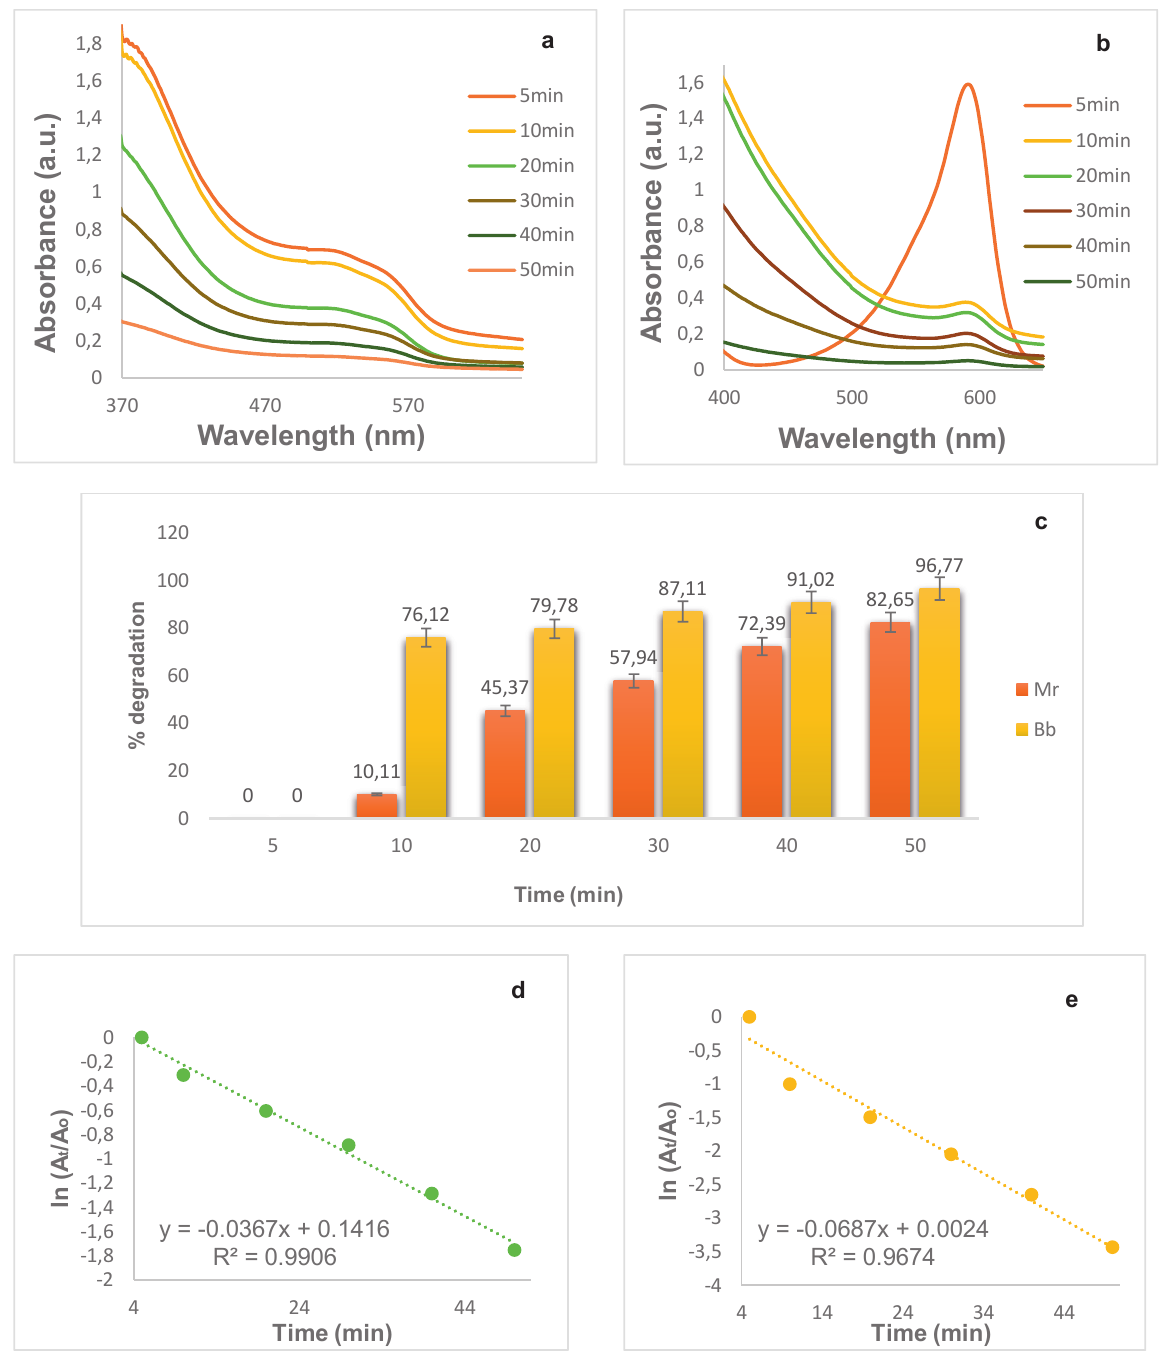
Figure 6: Alleviating UV-vis spectra expressing photocatalytic dye degradation potential of pomosynthetic ZnO nano falcates calcined at 400 : a) methyl red, b) bromophenol blue, c) percent degradation, d) e) ln (A ℃